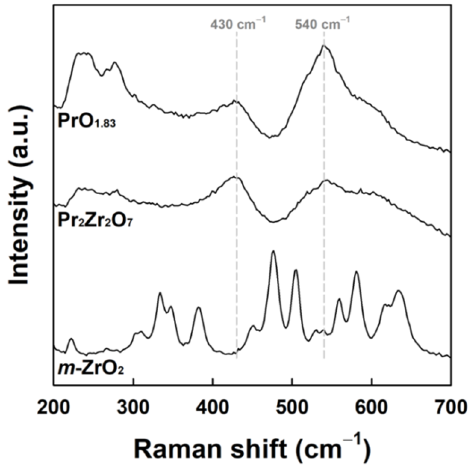
Figure 3. Raman spectra of m-ZrO 2 , Pr 2 Zr 2 O 7 , and PrO 1.83 .